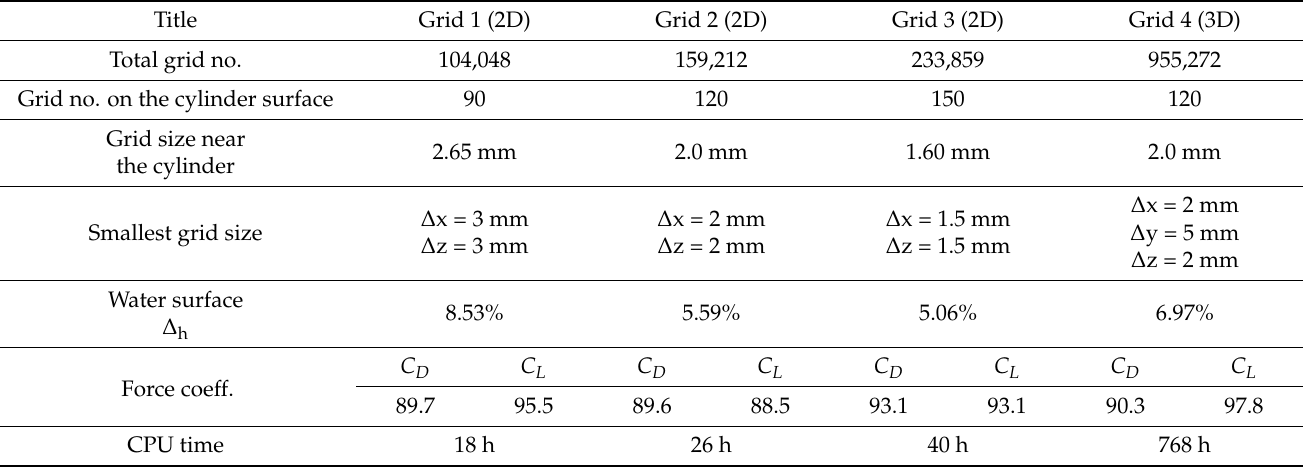
Water surface ∆ Force